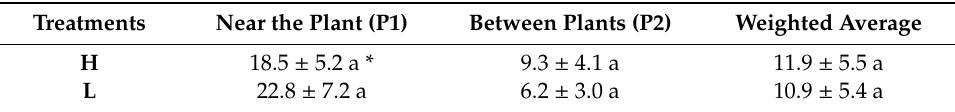
Table 5. Total root biomass (g m − 2 ) of an autumn–winter cucumber crop grown under two soil water availability treatments (H: High soil water availability; L: low soil water availability) for two soil positions, and weighted averages using fitted